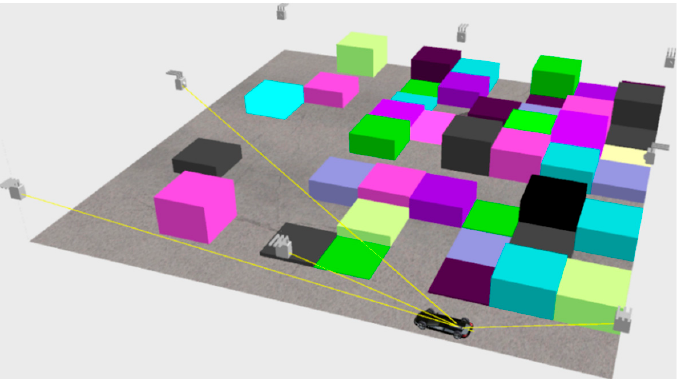
Figure 11. CarSim simulation scenario layout and screenshot of simulation process.